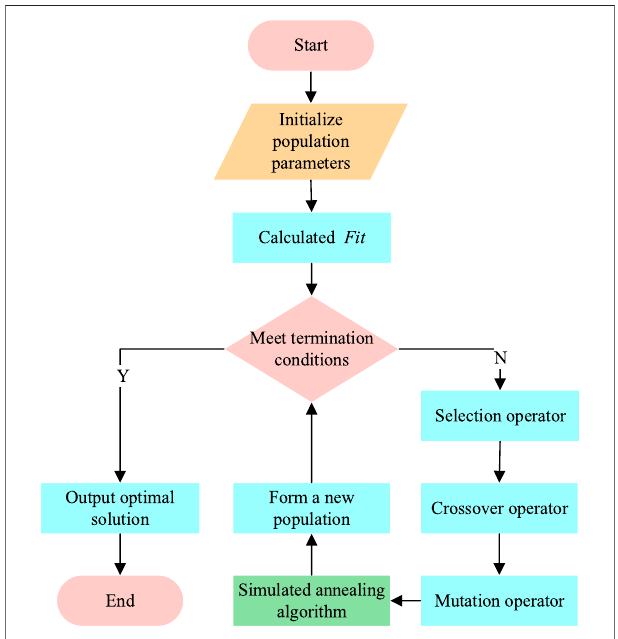
FIGURE 1 | Flow chart of optimized